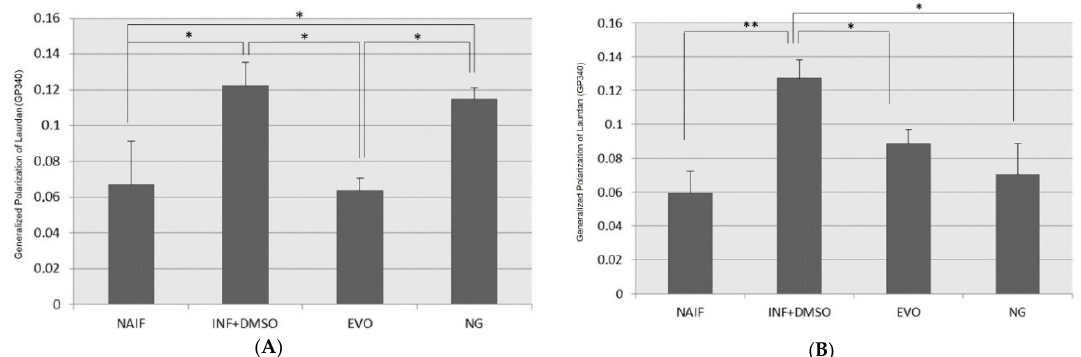
Figure 8. Assessment of membrane fluidity after treatment under the two experimental conditions: ( A ) SET1; ( B ) SET2. *: p < 0.05; **: p < 0.01.